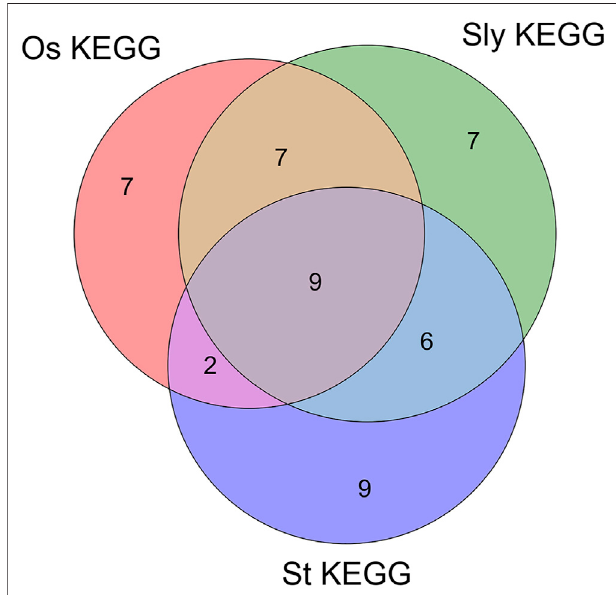
FIGURE 7 | Venn diagram of three fungal sRNA targeting plant KEGG_pathway. In the fi gure, Os_KEGG is the KEGG_Pathway of Magnaporthe oryzae targeting Oryzasativa .Sly_KEGG istheKEGG_Pathway of Botrytis cinerea targeting Solanum lycopersicum . St_KEGG is the KEGG_Pathway of Phytophthora infestans targeting Solanum tuberosum